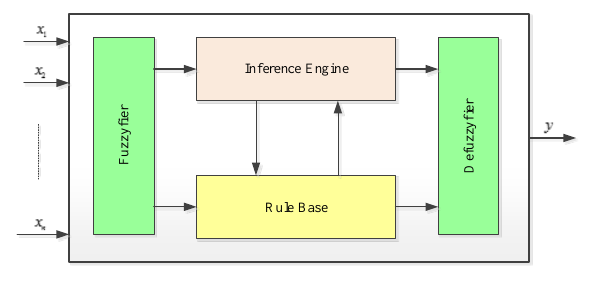
Figure 7. MISO fuzzy control